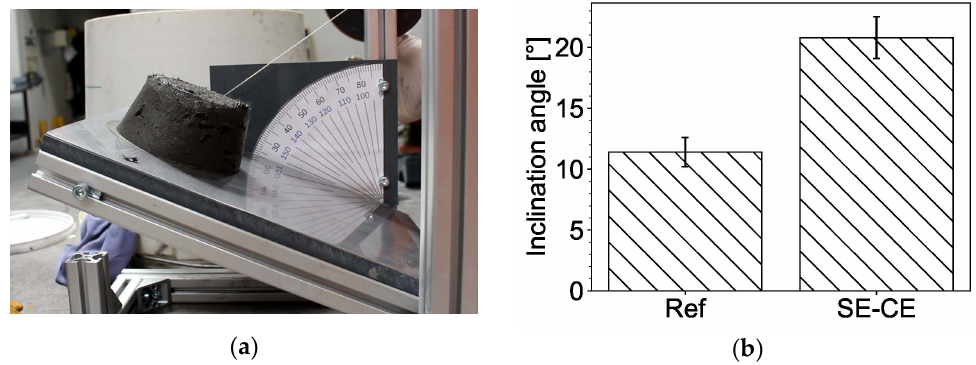
Figure 12. Inclined table test ( ITT ): ( a ) testing process and ( b ) comparison between the results for the compositions under investigation.